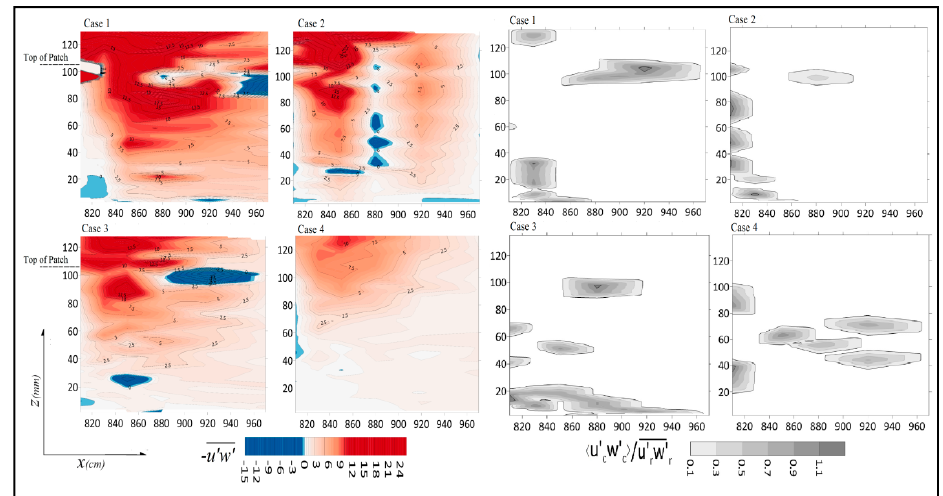
Figure 5. Values of − u (cid:48) w (cid:48) along the centerline of the channel beyond the vegetation patch (colored figures) beside values of τ c / τ r (graysclae). Note that the blank area in τ c / τ r is where no dominant frequency was detectable in S uw . The end of the patch is located at x = 800.